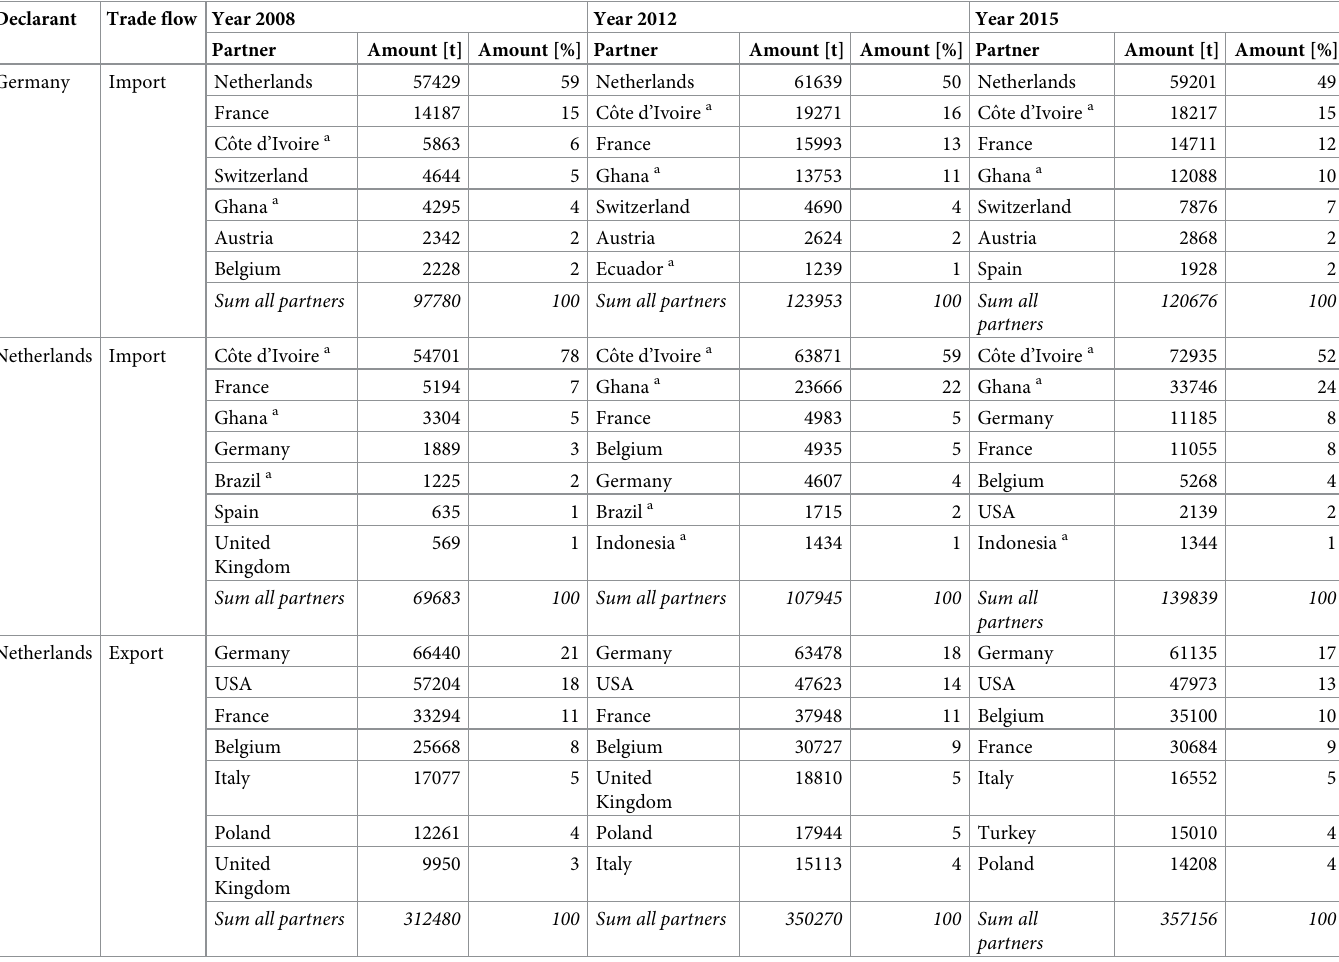
Table 6. Trade flows of cocoa powder and cocoa mass for Germany and the Netherlands according to Eurostat in the years 2008, 2012 and 2015. Evaluations are based on the database Eurostat [38] using the software Warenstrom-Info [39]. HS code 18031000 “cocoa mass excl. defatted” and HS code 18050000 “cocoa powder, not containing added sugar or other sweetening matter” were